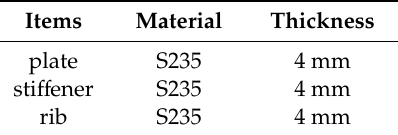
Figure 15. Photographs of the stiffened panel. Table 1. Thickness of the stiffened plate.